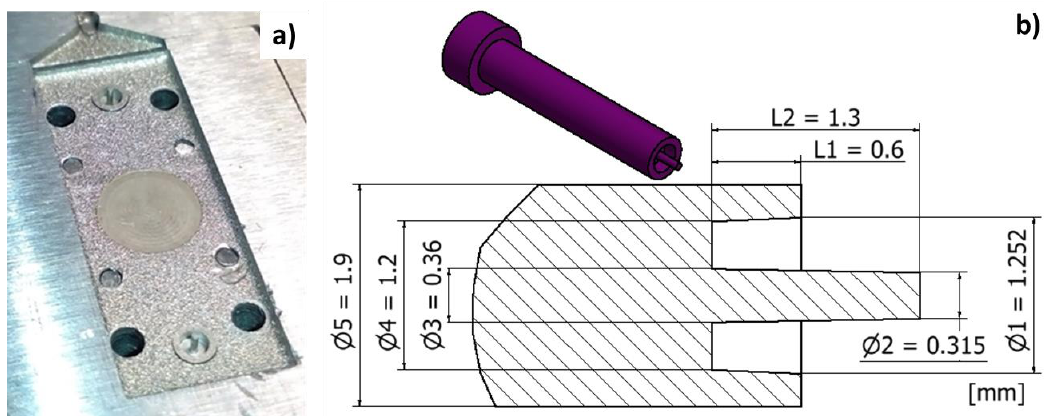
Figure 7. ( a ) Overview of the µEDM inserts with the capillary tube housing inserts and central circle machined with low roughness and ( b ) main dimensions of the capillary tube housing insert .